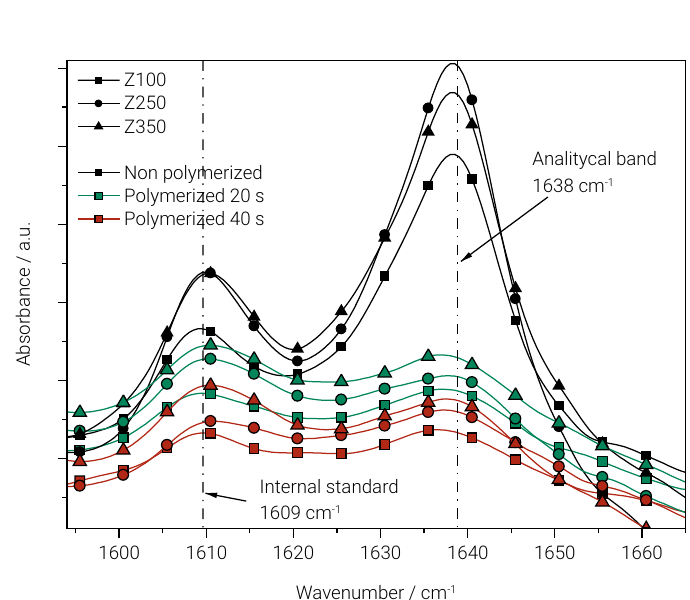
Figure 1. FTIR spectra exhibiting the reduction in the peak height at 1638 cm -1 associated with the saturation of aliphatic C=C within the resin-based methacrylates (Z100, Z250 and Z350XT). Absorption of the aromatic C=C stretching band (1609 cm -1 ) remains constant during